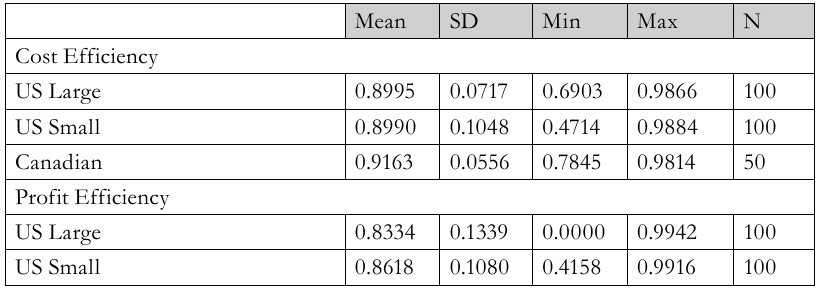
Tab. 4 – Cost efficiency and profit efficiency by group based on different methods. Source: author’s own